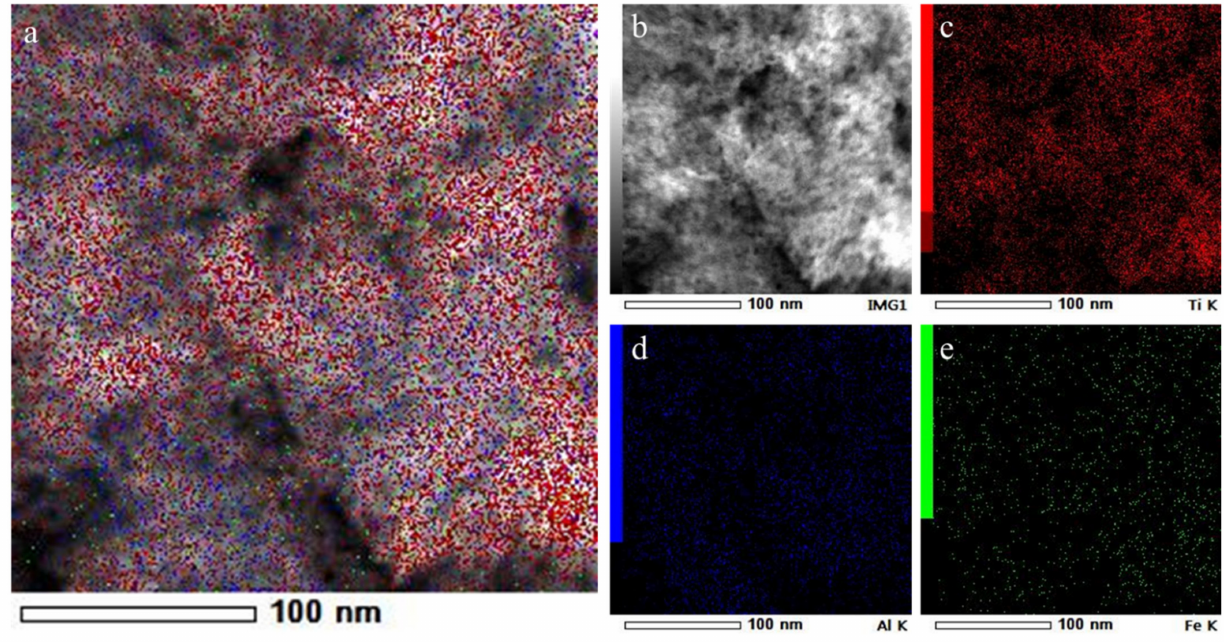
Figure 4. Images of: ( a ) TEM-EDX, ( b ) TEM images, and K α maps of: ( c ) titanium; ( d ) aluminum; and ( e ) iron for Fe/Mt/TiO 2